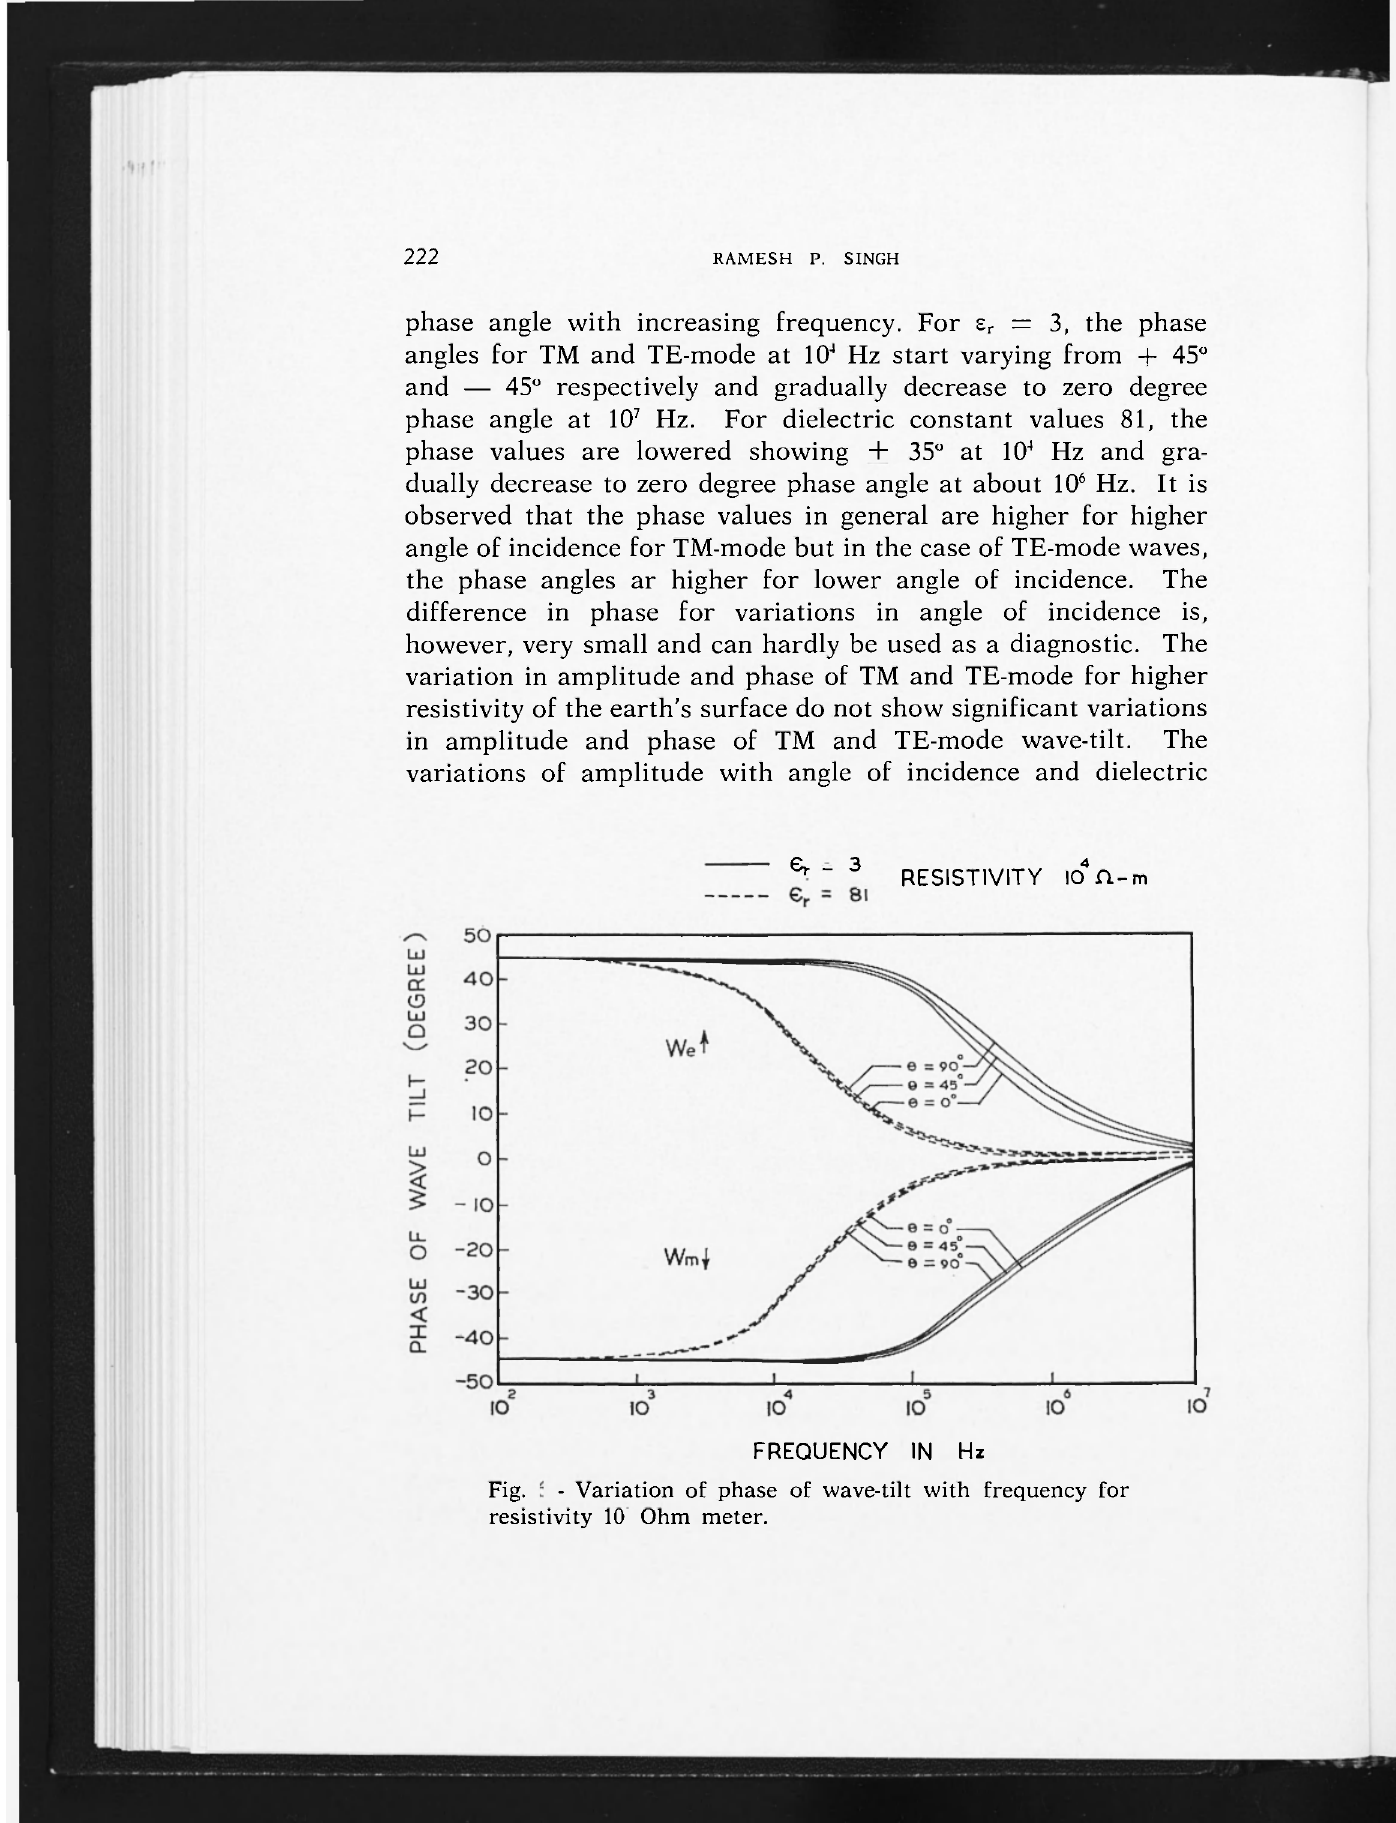
Fig. 4 - Variation of phase of wave-tilt with frequency for resistivity 10 2 Ohm